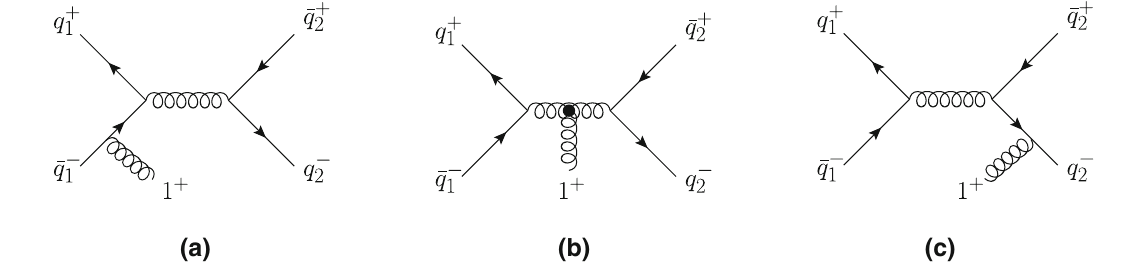
Fig. 1 The three diagrams contributing to the partial helicity amplitude M ( 0 → q −